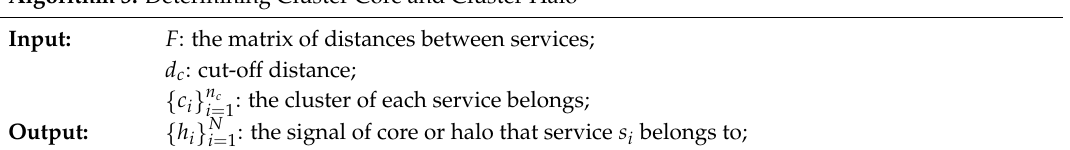
Algorithm 3. Determining Cluster Core and Cluster Halo